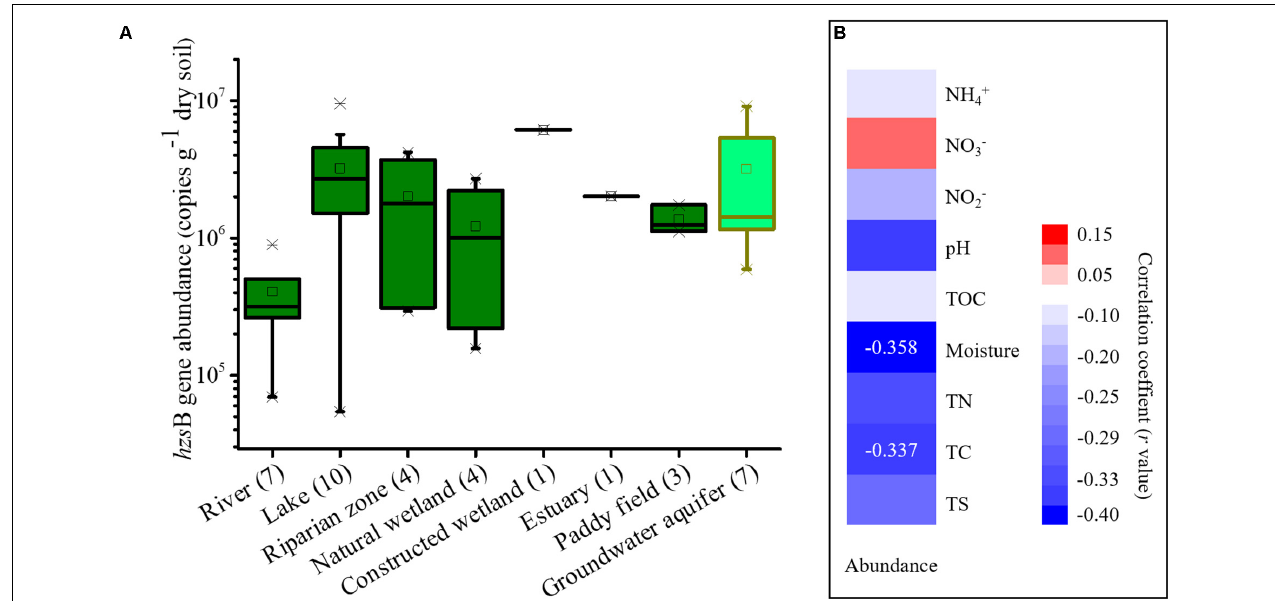
FIGURE 3 | Boxplots showing the abundance of the hzs B gene in each wetland habitat and groundwater aquifer. (A) and a correlation analysis of anammox bacterial abundance and chemical parameters (B) . The dryland and snow samples failed to be quantified by qPCR assay due to their extremely low abundance. In this figure mean values are indicated by the open square, the central horizontal bars are the medians, and the box lower and upper limits are the 1st and 3rd quartiles, respectively. Crosses are minimum/maximum values. Sample numbers are indicated after the habitat